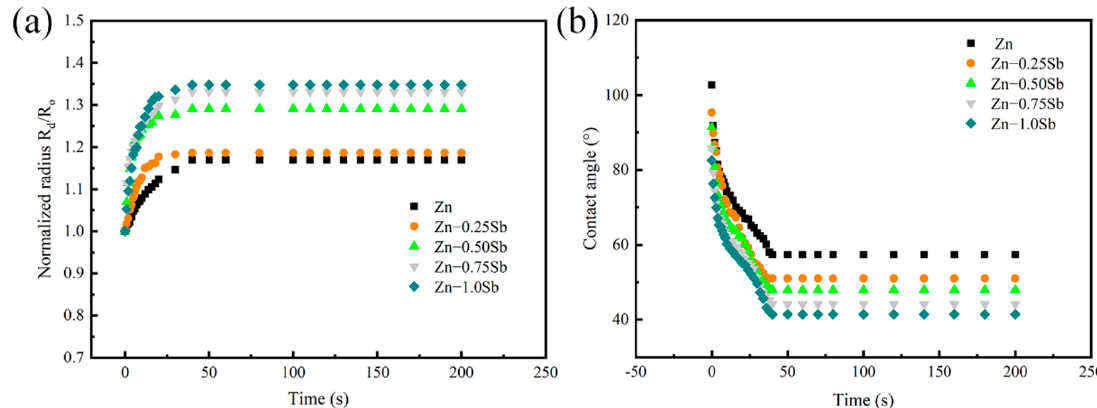
Figure 2. Changes in contact angle and normalized radius over time.